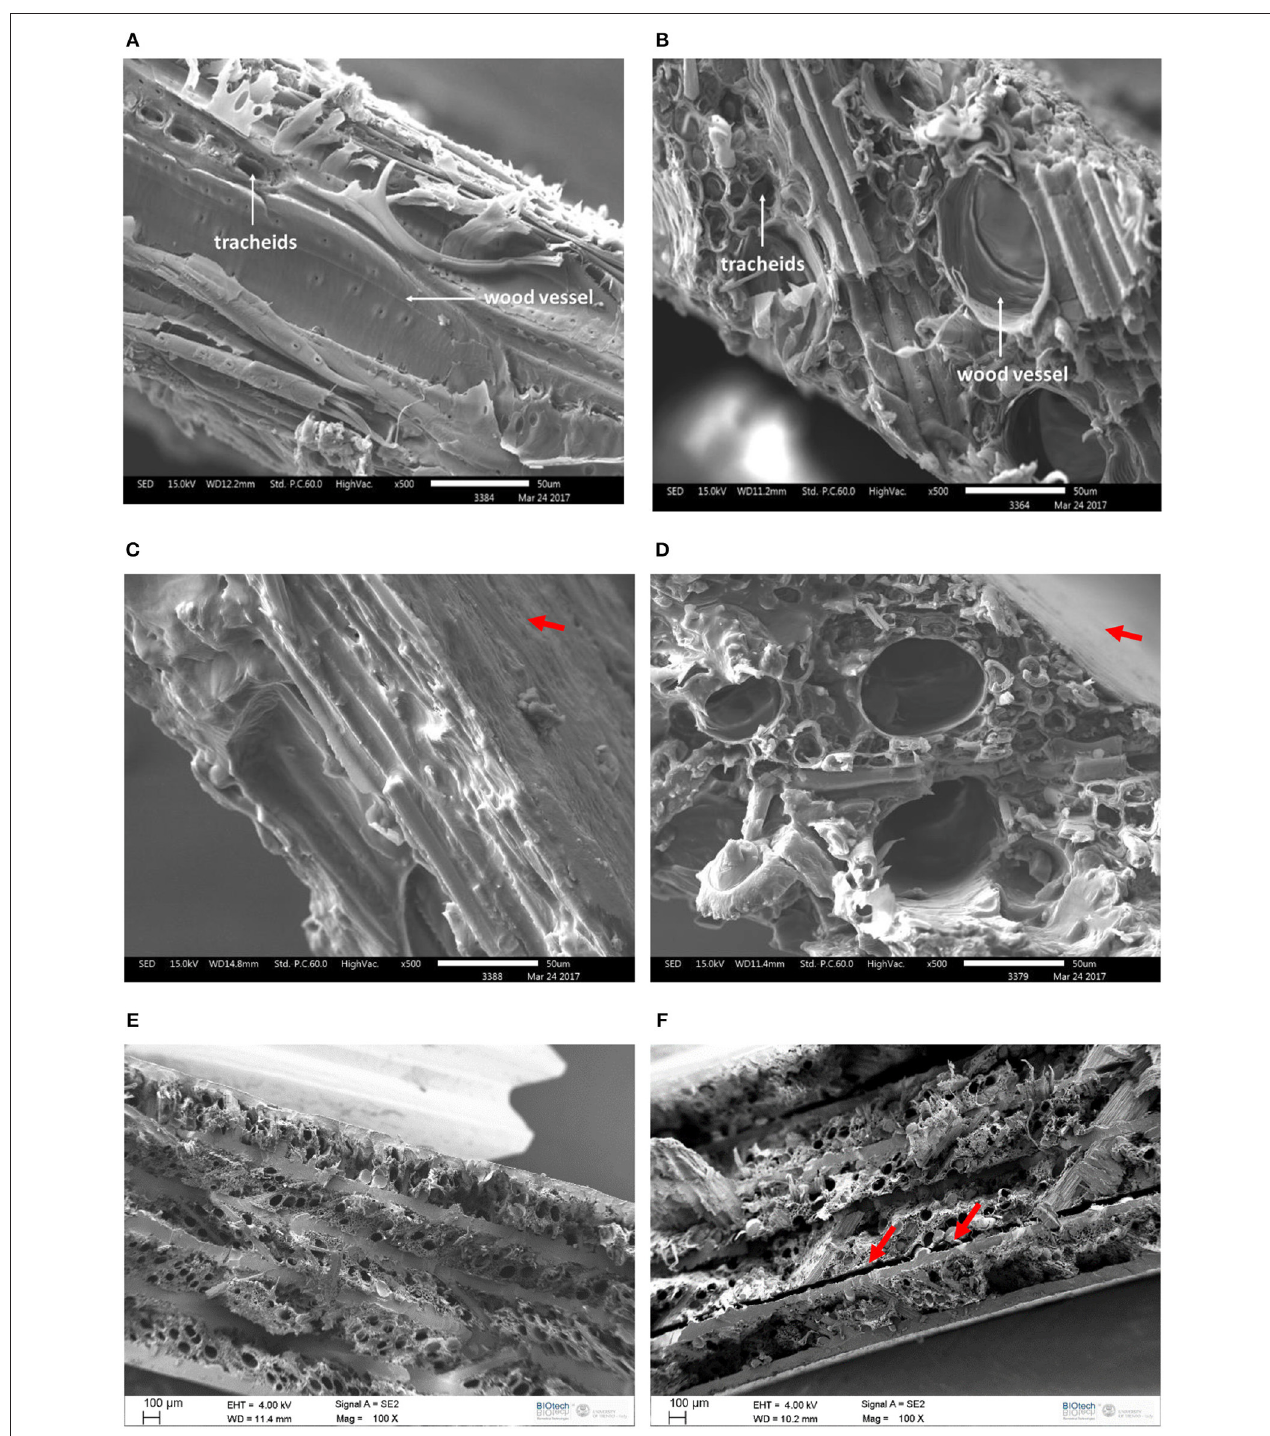
FIGURE 2 | SEM micrographs of the cryofracture surface (cross-section) of the prepared samples. (A) F-T; (B) F-L; (C) FP-T; (D) FP-L; (E) FA-T; (F) LAM-T.